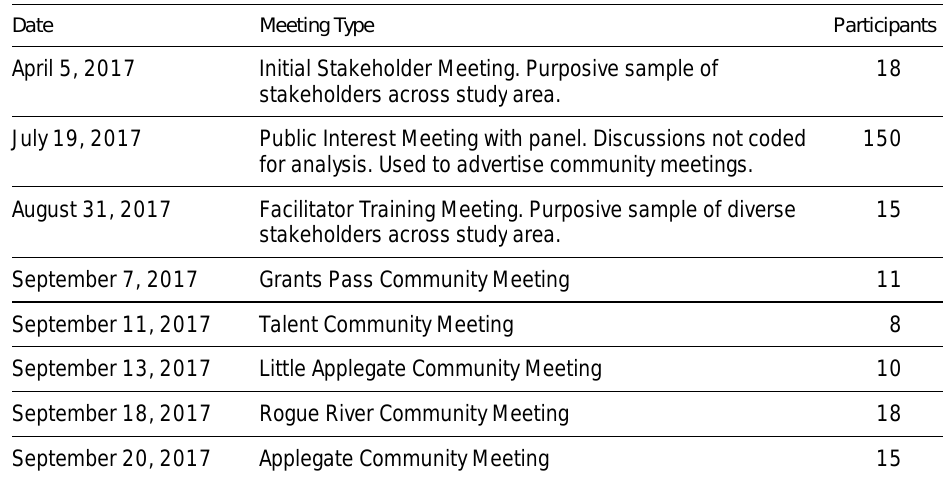
Table 1. Description and Timing of Cannabis Community